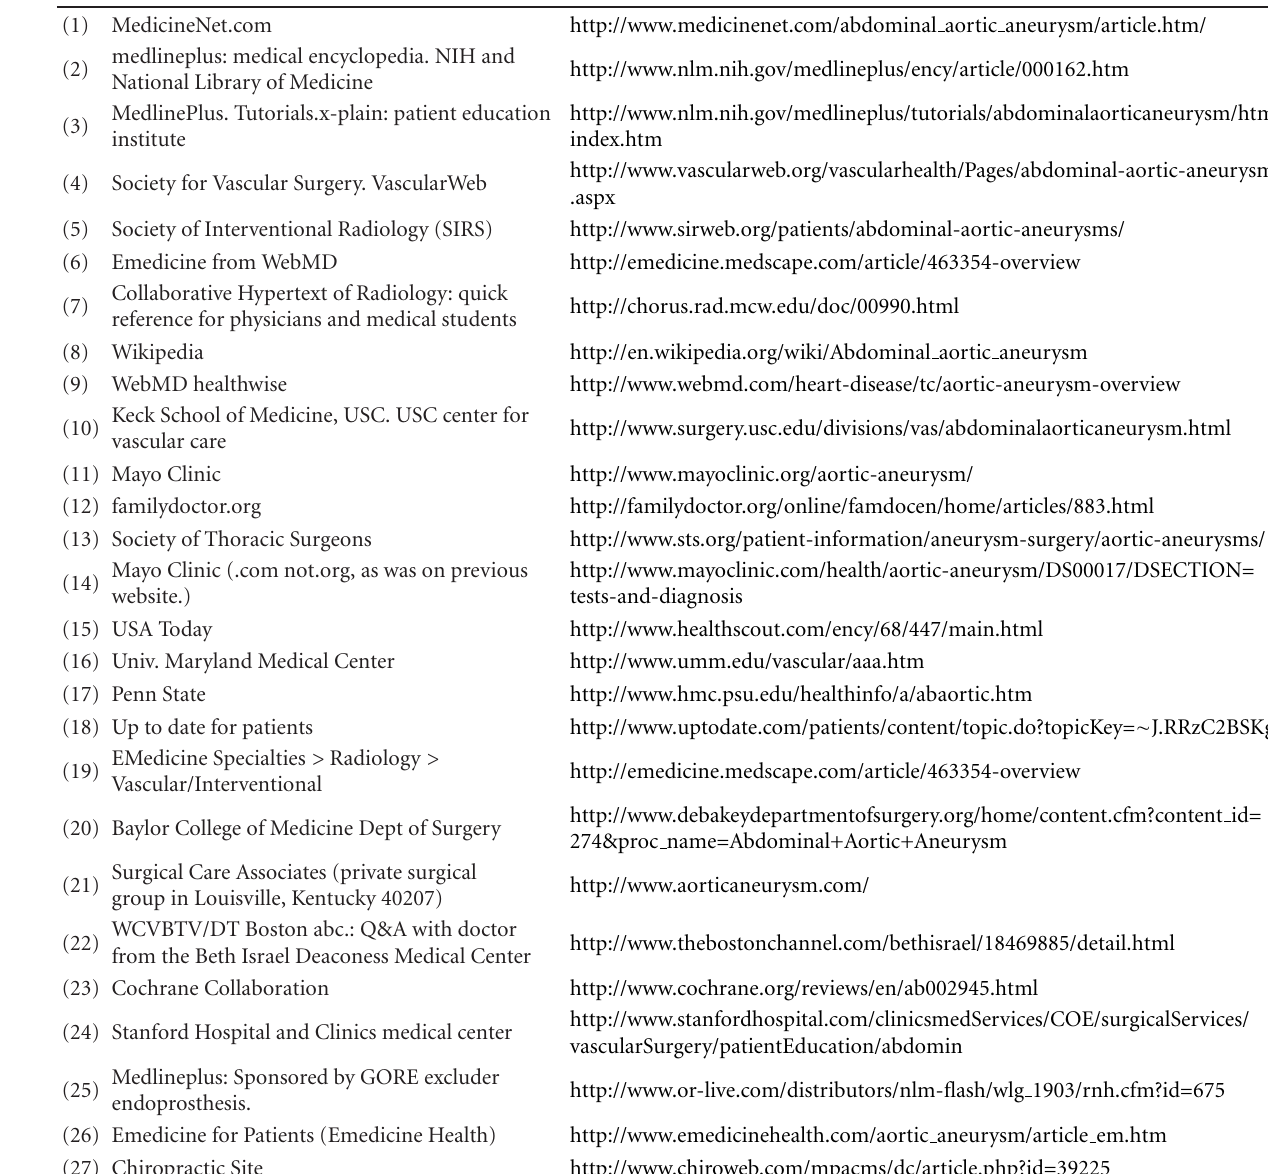
Table 4: Evaluated